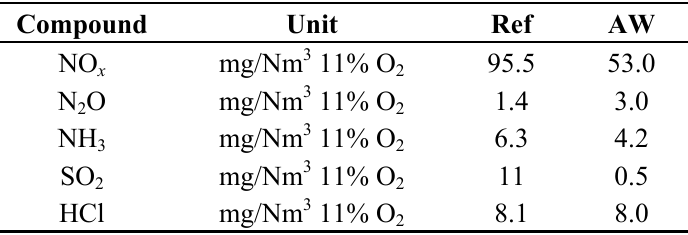
Table 6. Flue gas